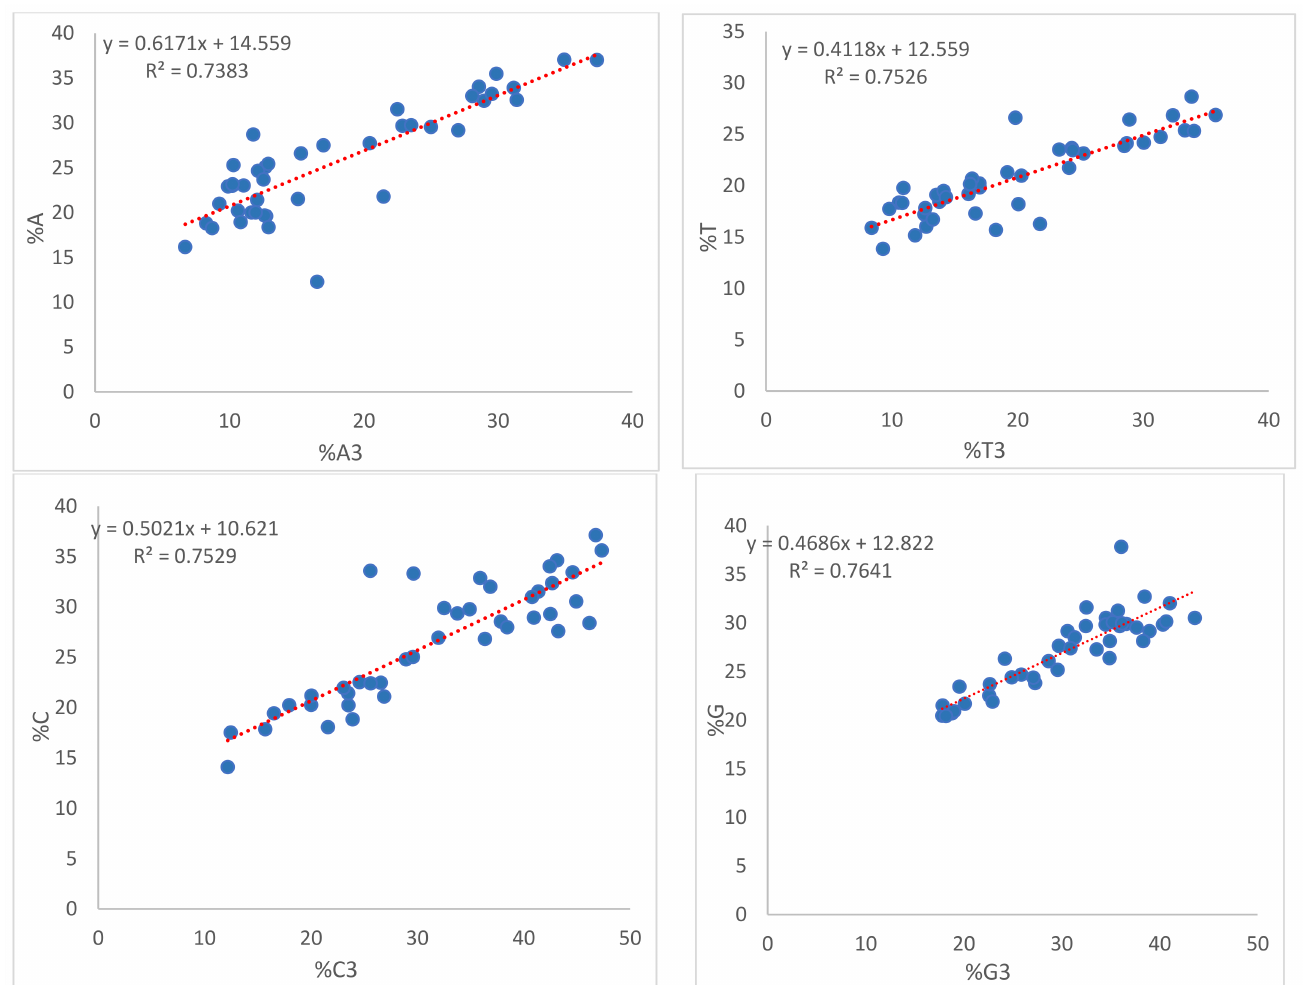
Figure 12. Regression analysis between the overall nucleotide composition and composition at the third position of the